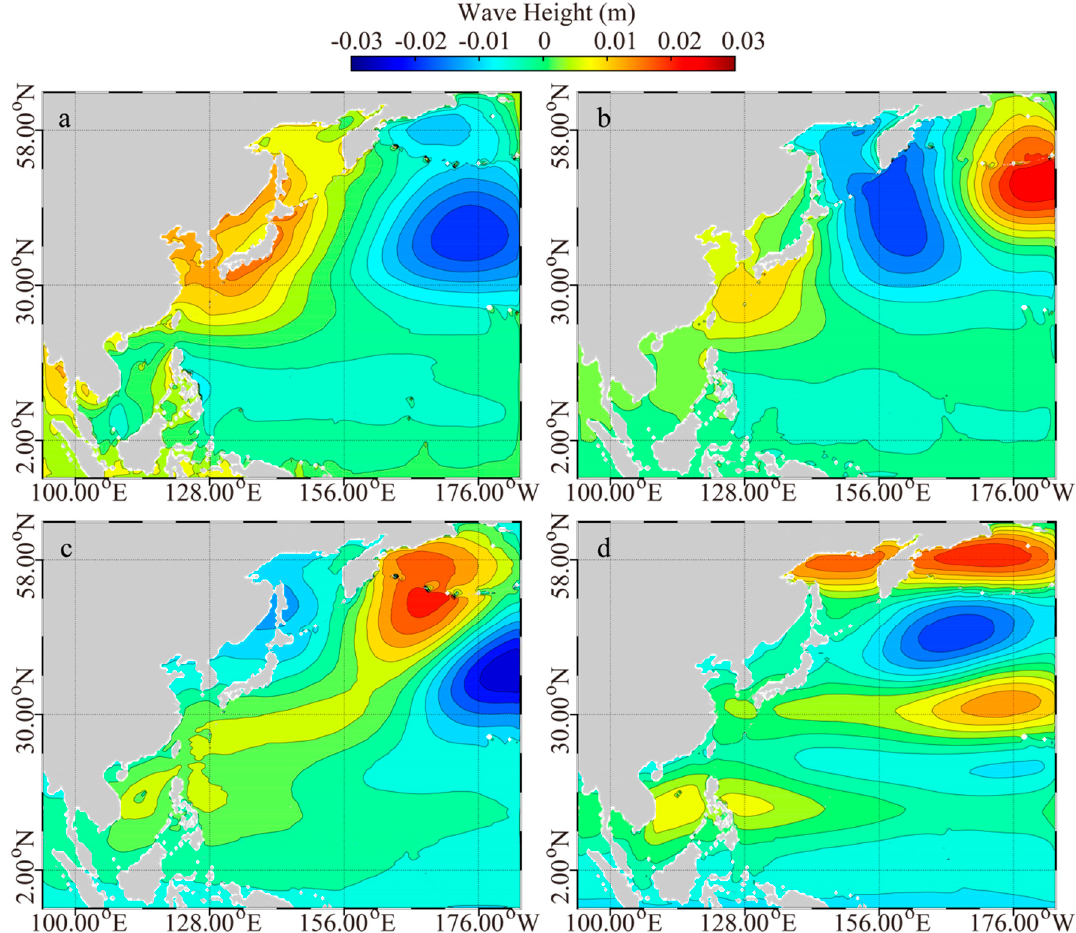
Figure 9. Spatial distribution of the four dominant EOF modes for average SWH from 1998 to 2018. ( a ) The first mode; ( b ) the second mode; ( c ) the third mode; and ( d ) the forth mode.